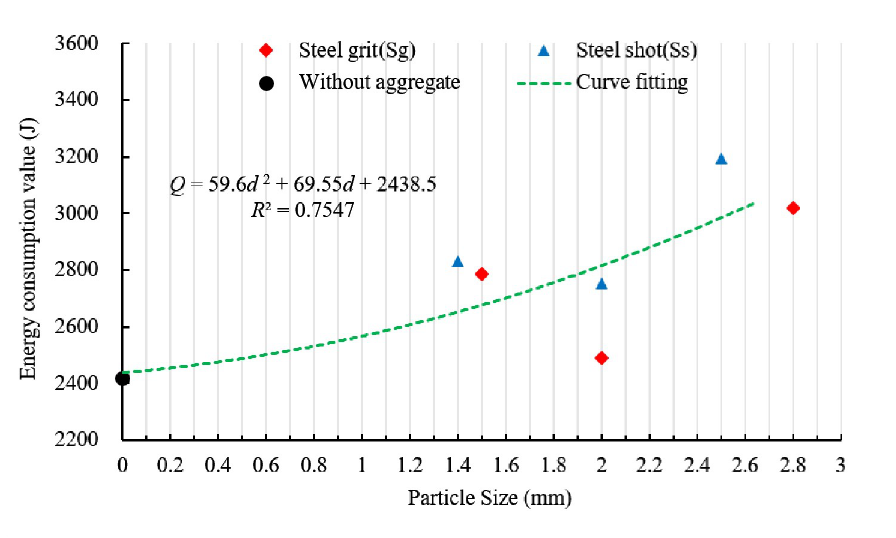
Fig 19. Scatter plot of energy consumption and fitting curve of different aggregate sizes.